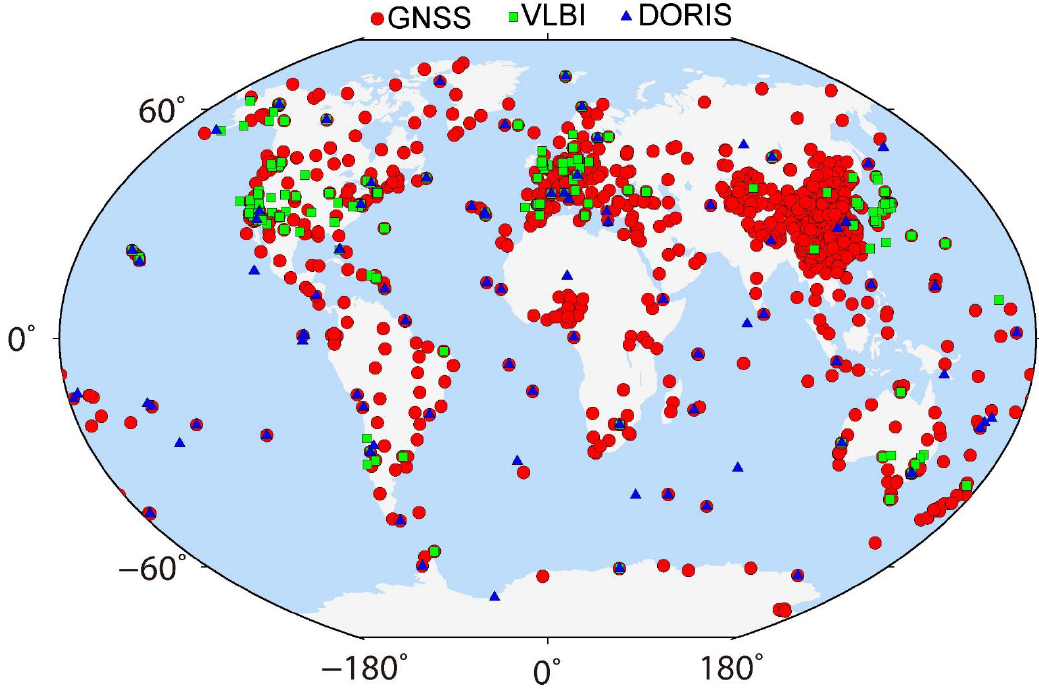
Figure 1. Distribution of GNSS (red circles), VLBI (green squares) and DORIS (blue triangles) stations included in WTM model.